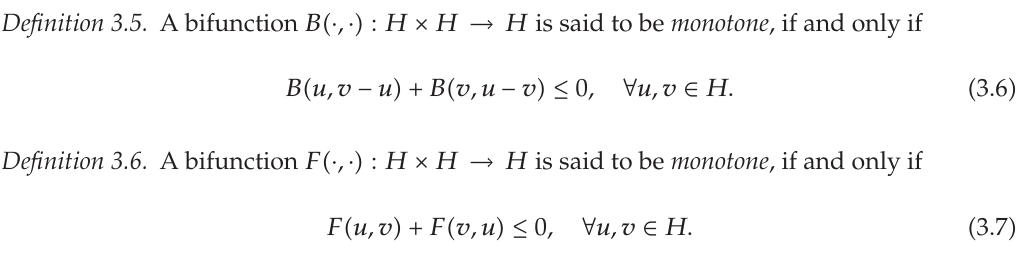
Algorithm 3.4. For a given u 0 ∈ K , compute the approximate solution u n (cid:7) 1 by the